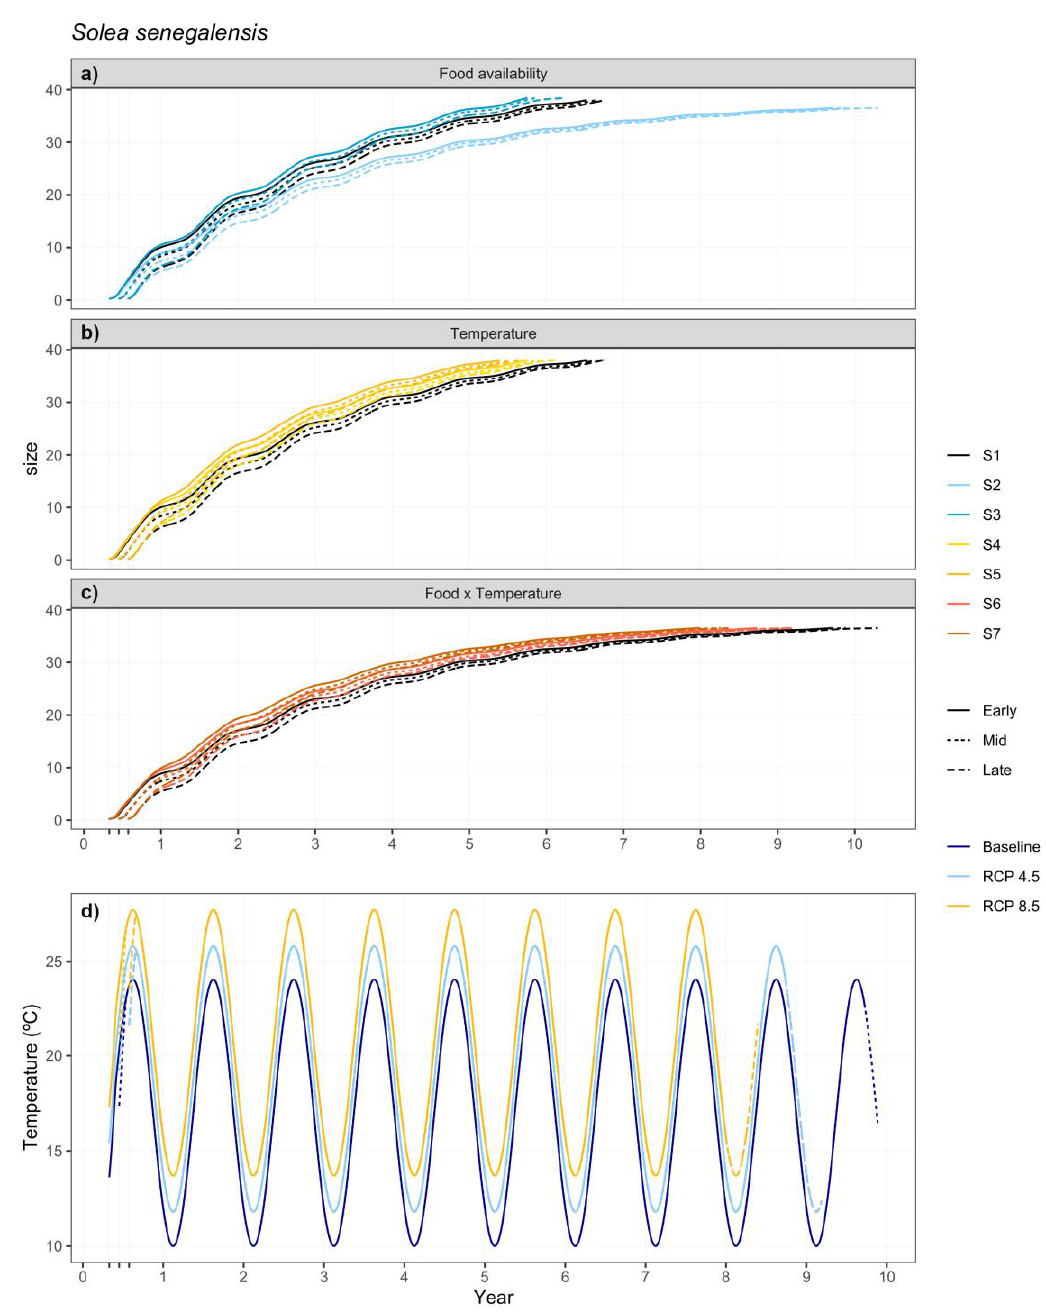
Figure 6. DEB model growth simulations for S. senegalensis individuals spawned at three different times of the year (represented by full, dotted, and dashed lines) under baseline conditions (S1, black lines in panels a-c), and ( a ) magnitude changes of food (±50% X, S2 and S3, blue lines), ( b ) temperature rise scenarios (+1.8°C and 3.7°C, yellow lines) and ( c ) their combination (S6 and S7, orange lines). ( d ) Temperature during the simulation, representing the temperature experienced by the larvae and juveniles, i.e., it includes the gradual shift from coastal sea to estuary (see Methods for details). Please see Table 1 for the summary of scenario descriptions.